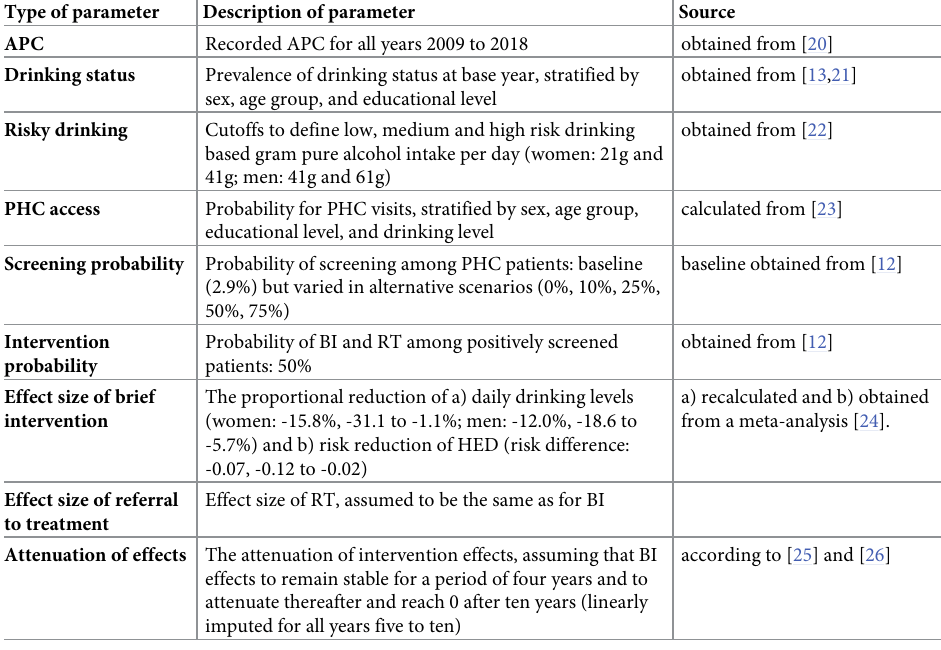
Table 1. Description and sources of simulation